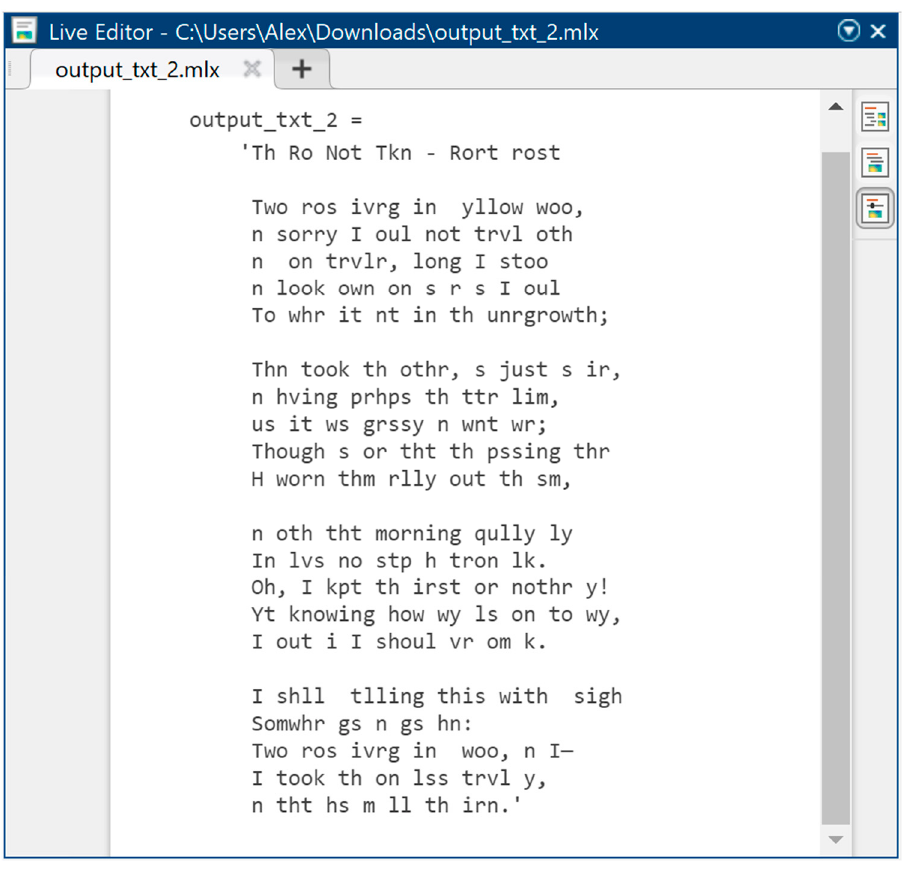
Figure 13. Recovered text information after 30-times compression of steganocoded audio signal (developed method).